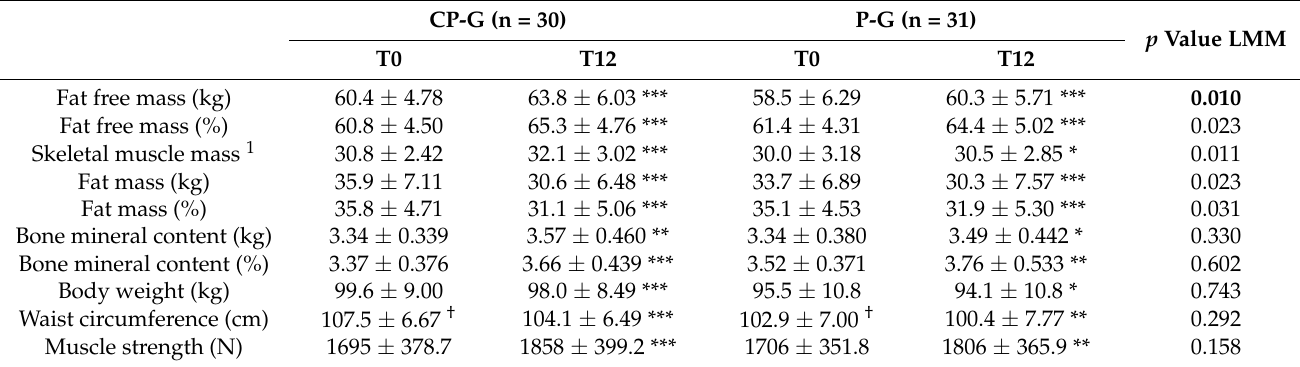
Table 2. Efficacy outcomes at baseline and following supplementation with collagen peptides or